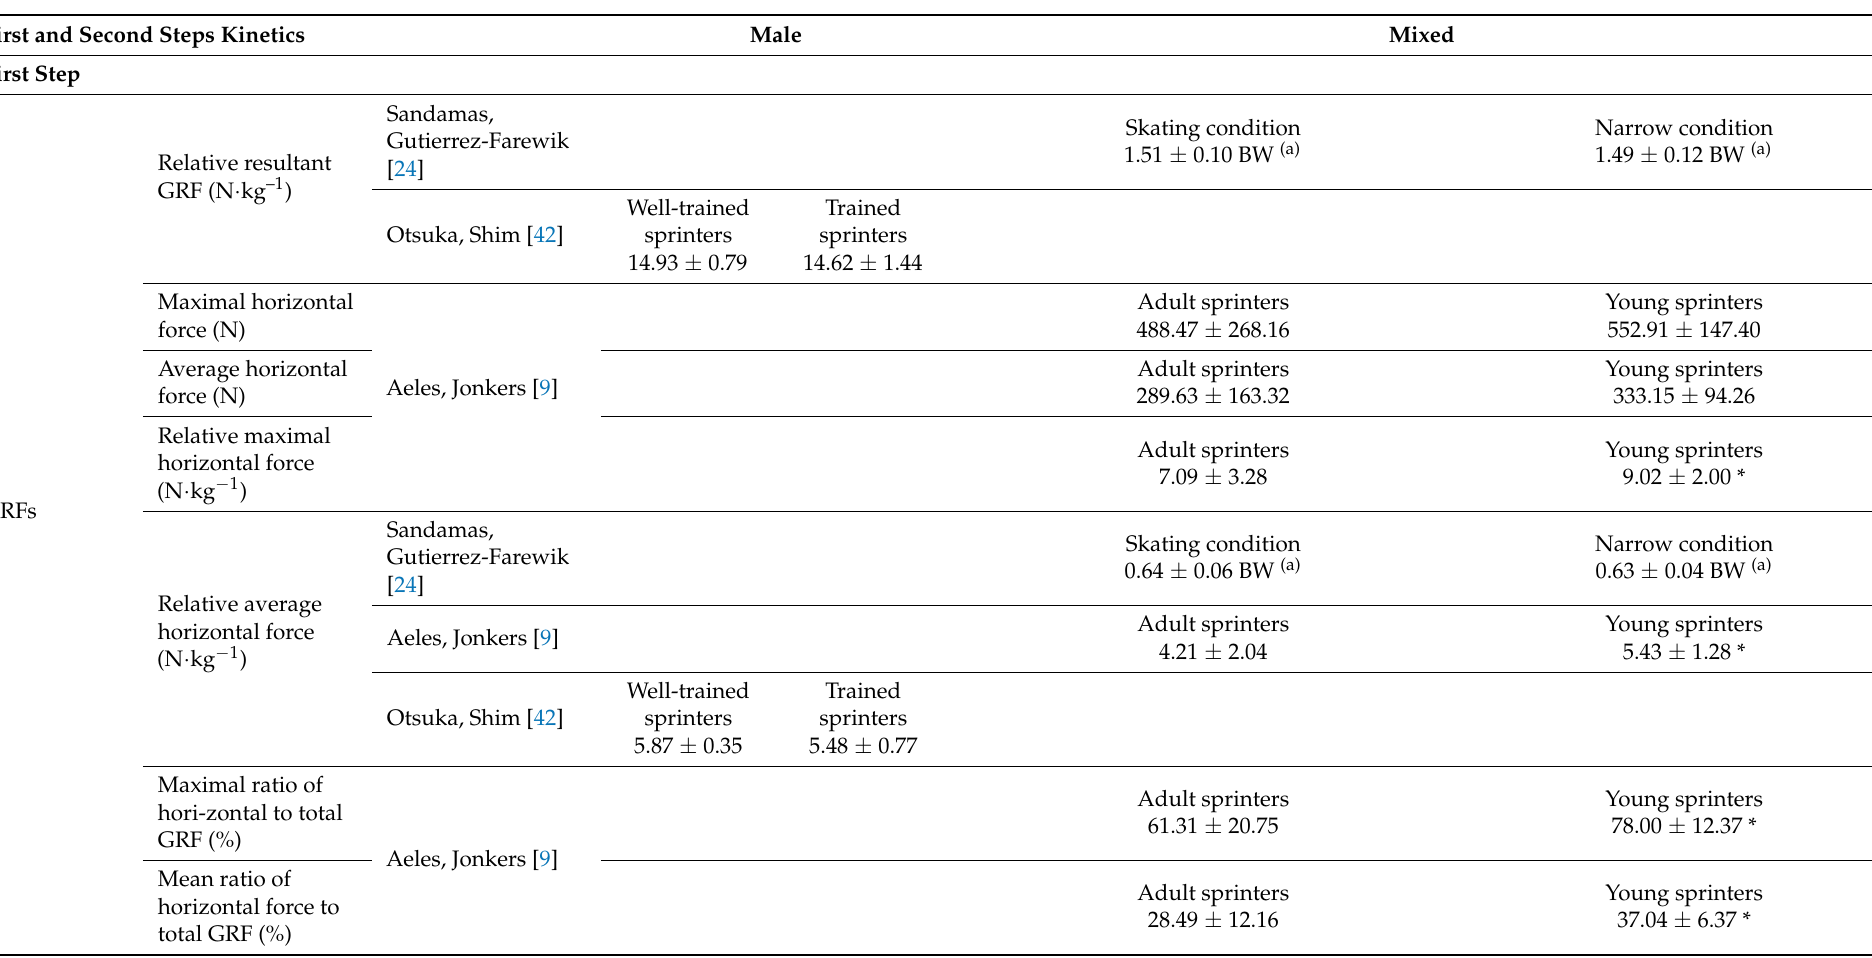
Table A5. Summary of the kinetic variables in the “first two steps”. Data are the magnitude of the mean ± SD presented in the reviewed studies. Groups are male and mixed (when authors joined data without discriminating by sex) sprinters. Studies are listed, in each variable, in reverse chronological order, followed by alphabetically for studies published in the same year. Data, terms, conditions, and sprinters’ performance levels are presented according to the original authors. Statistical differences between groups are marked with asterisks (* p < 0.05; *** p < 0.001; # significant different from adults;